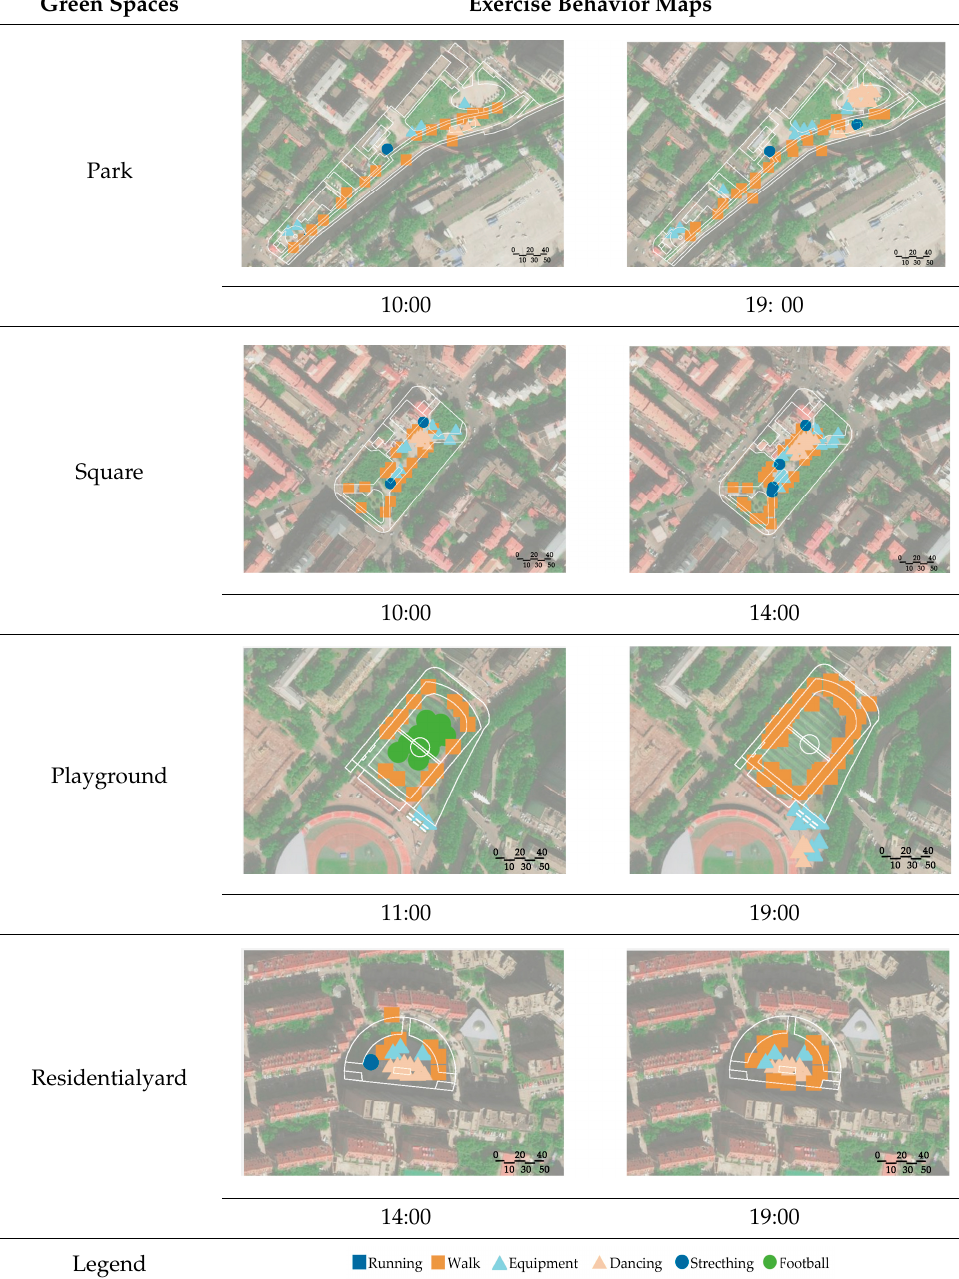
Table 10. The sunlight conditions of the observation sampling sites during the peak period.